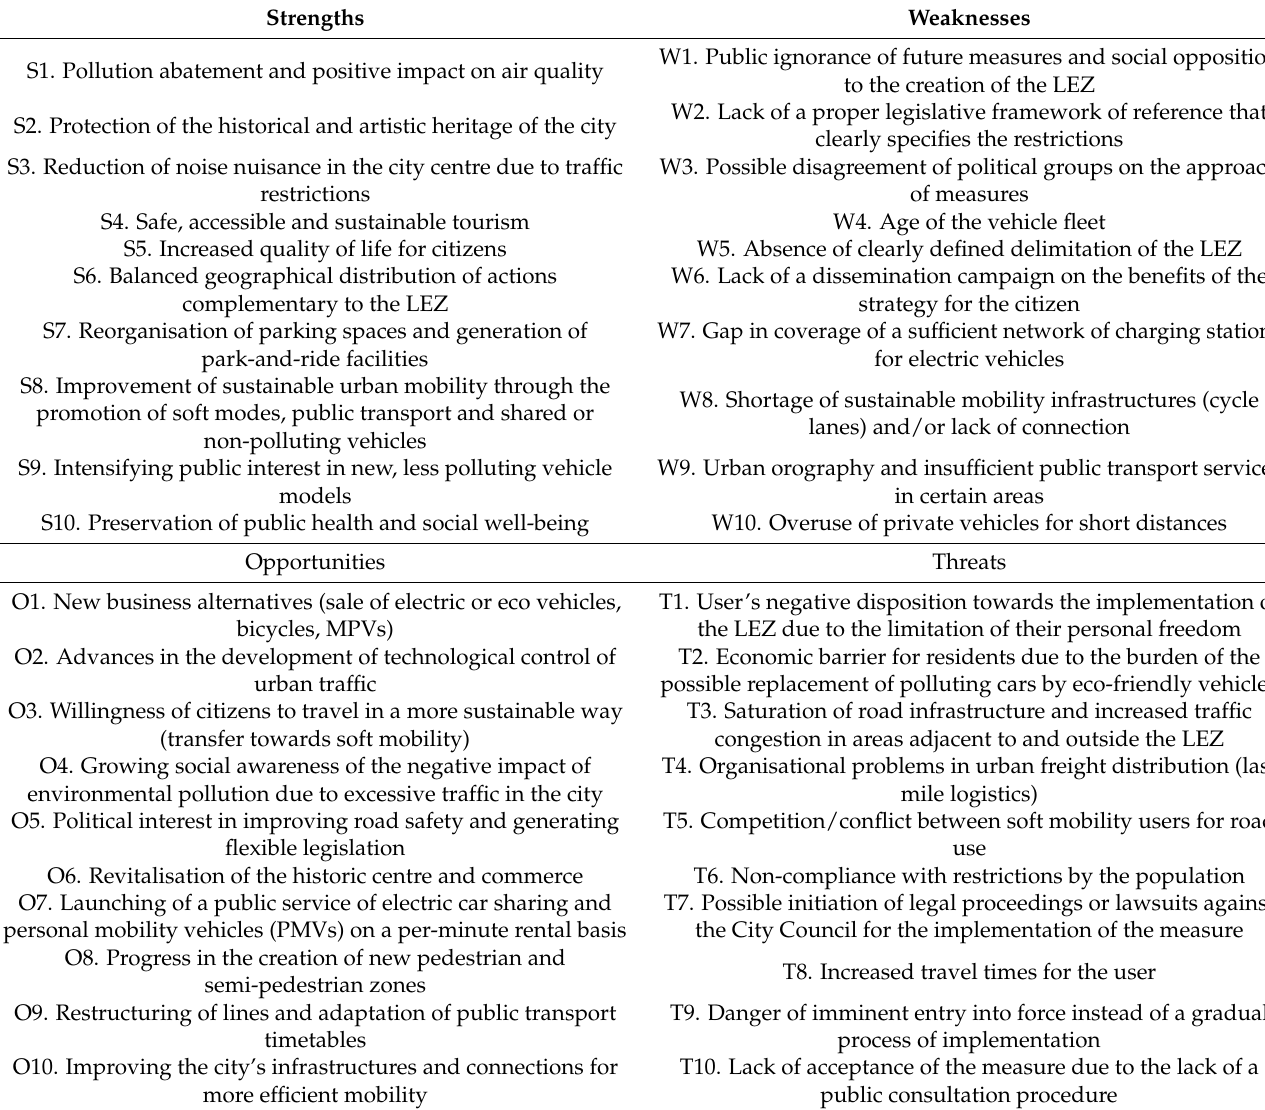
Table 8. SWOT analysis of the possible implementation of an LEZ in C á